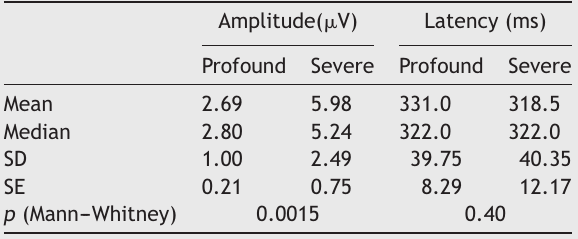
Descriptive measures of latencies (ms) and ampli- tude ( (cid:2) V) of P300, according to the variable degree of hearing loss.